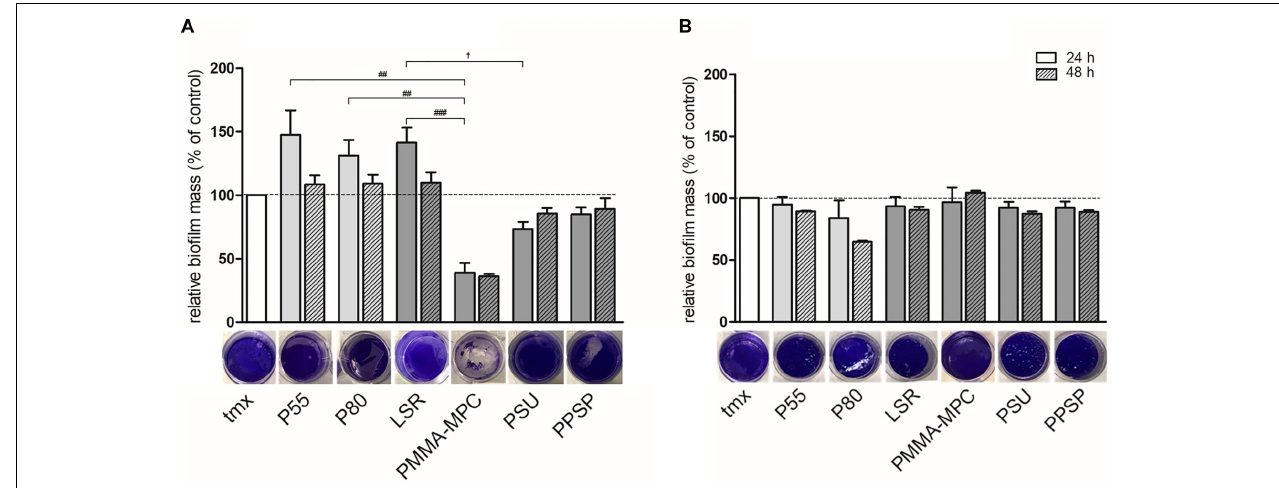
FIGURE 6 | LSR coated with polymethylmethacrylate-2-methacryloyloxyethyl phosphorylcholine (PMMA-MPC) significantly reduces S. aureus biofilm formation. Materials were incubated with 2 × 10 8 CFUs of (A) S. aureus and (B) S. epidermidis and biofilm formation was quantified after 24 h and 48 h by crystal violet staining. Representative pictures of biofilm formation stained with crystal violet after 24 h are shown. Values were normalized to tmx control (100%). Data are represented as mean + SE Mean of three independent experiments carried out in duplicates. Significances: # vs. PMMA-MPC: ## p < 0.01, ### p < 0.001; † vs. PSU: † p < 0.05.